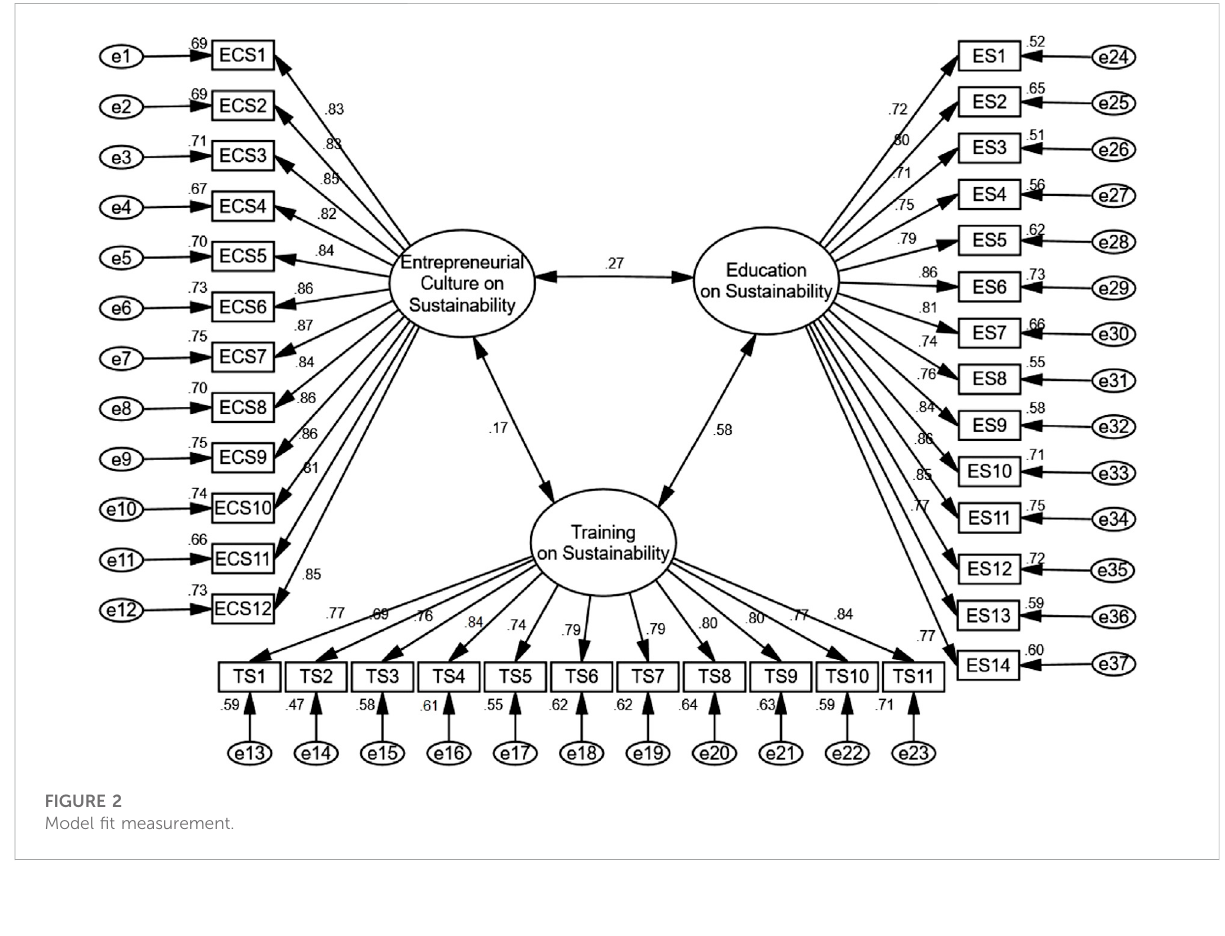
TABLE 2 Model Fit Evaluation.